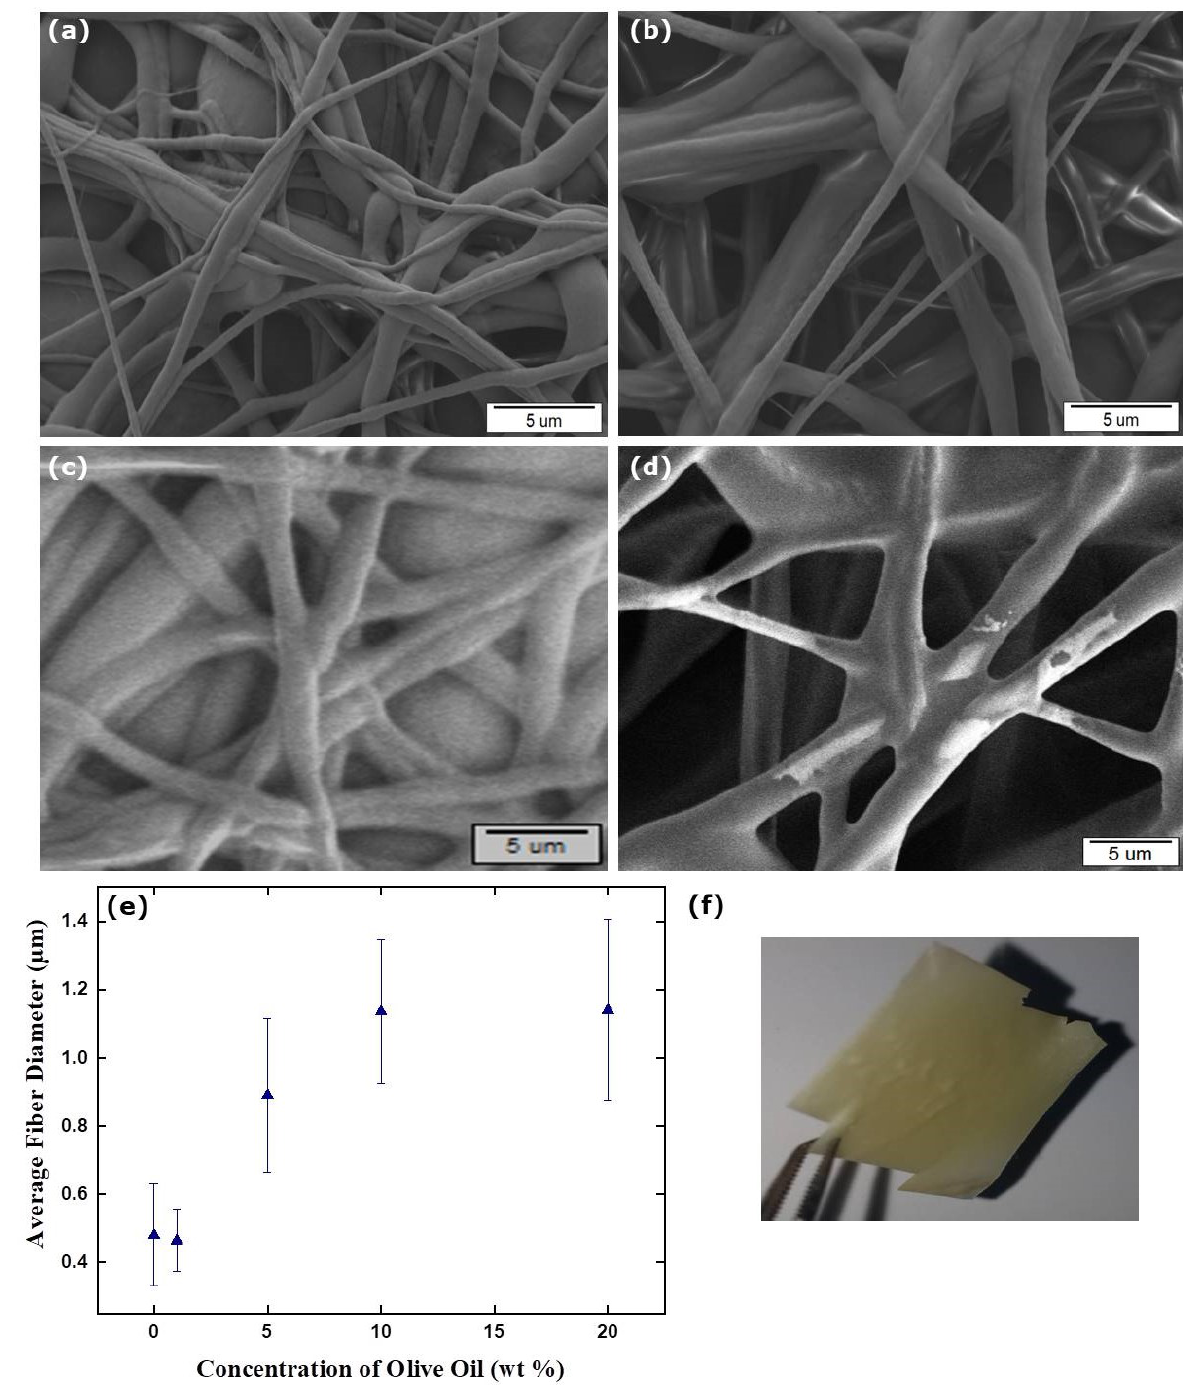
Figure 5. SEM micrographs with different concentrations of OO: ( a ) 1 wt %, ( b ) 5 wt %, ( c ) 10 wt %, ( d ) 20 wt %, the diameter distribution histogram ( e ), and photograph ( f ) of the TPU/OO fibers (applied voltage: 12.5 kV, flow rate: 1.00 mL h − 1 , distance: 17 cm, and TPU concentration in TPU/OO fibers: 12.5 wt